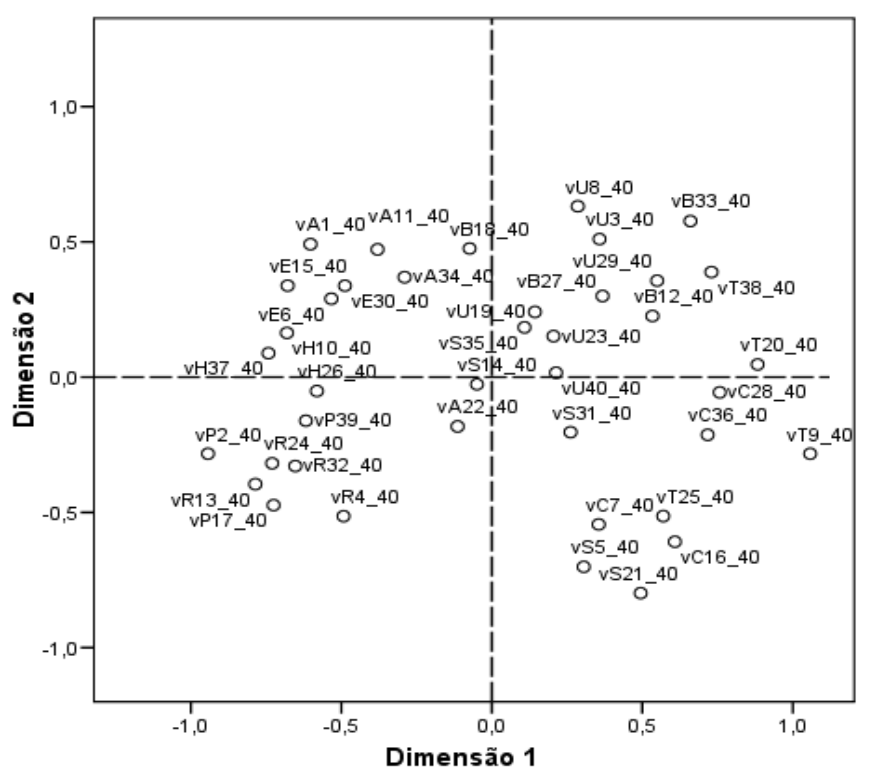
Figura 4. WCMDS por itens do